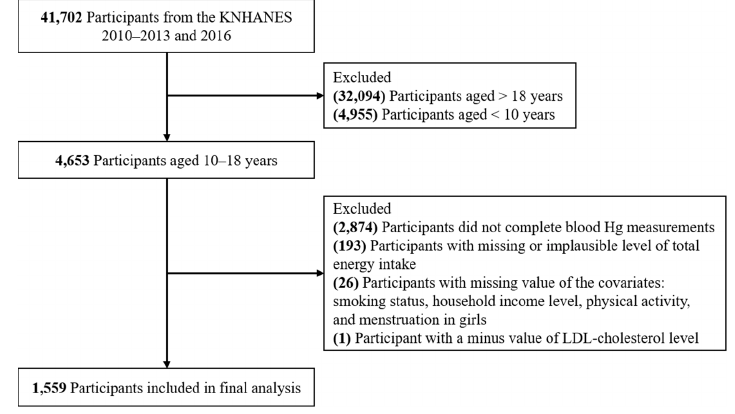
Figure 1. Flow diagram of the study participants.